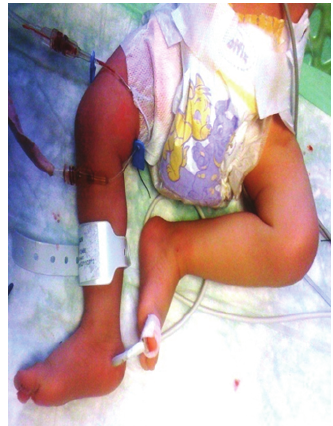
Figure 2: No ischemia after vascular